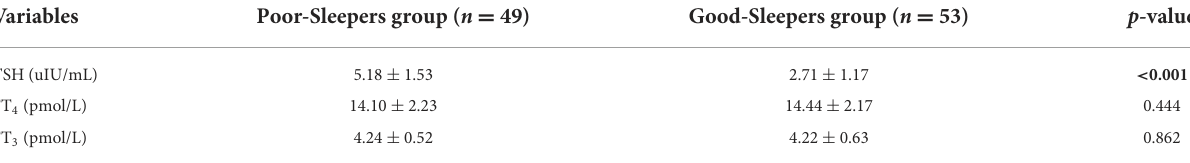
TABLE 5 Serum levels of FSH, FT 4 , and FT 3 of RLS by PSQI score.